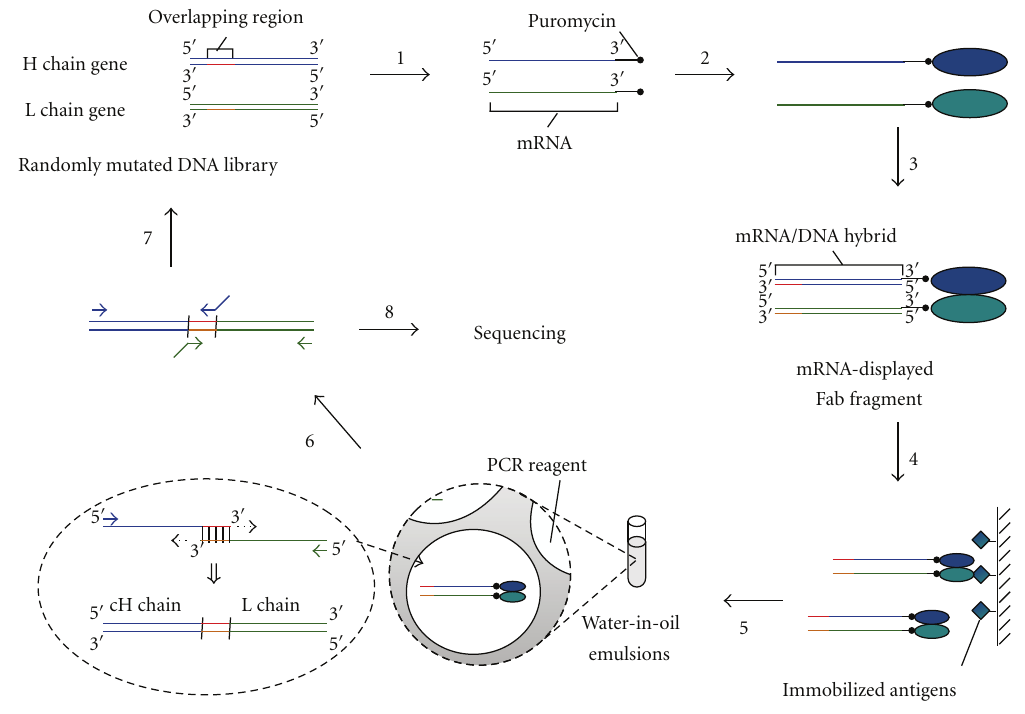
Figure 2: Scheme of in vitro selection of Fab fragments using mRNA display and emulsion PCR. Step 1: A randomly mutated DNA library of an H chain gene and an L chain gene is separately prepared. Each DNA library is transcribed and puromycin is ligated to the 3 (cid:2) end to make an mRNA template. Step 2: The mRNA template is translated to form an mRNA-displayed molecule. Step 3: The molecules are purified and subsequently reverse is transcribed to make the mRNA portion a DNA hybrid. The H and L chain molecules are combined to form an mRNA-displayed Fab fragment. Step 4: The mRNA-displayed Fab fragments are subjected to in vitro antigen selection. Step 5: The selected mRNA-displayed Fab fragments are recovered and mixed with PCR reagents. The mixture is emulsified and the corresponding H and L chain genes are linked together by overlap extension PCR. Step 6: The linked DNA is amplified by PCR again with di ff erent primers to regenerate the H and L chain genes. Step 7: The regenerated genes are reamplified by DNA shu ffl ing to make the templates for the next round of selection. Step 8: After a suitable number of rounds of selection, the selected DNA is cloned and sequenced to identify the selected Fab